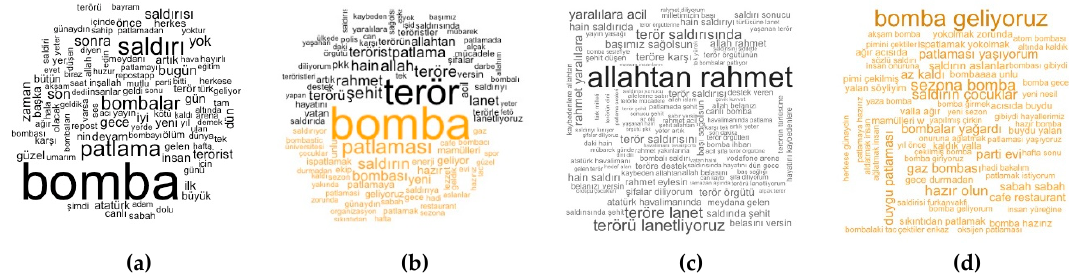
Figure 9. Keyword filtered tweets (a) commonality cloud; (b) comparison cloud; (c) bi-gram word cloud for relevant tweets; (d) bi-gram word cloud for non-relevant tweets.